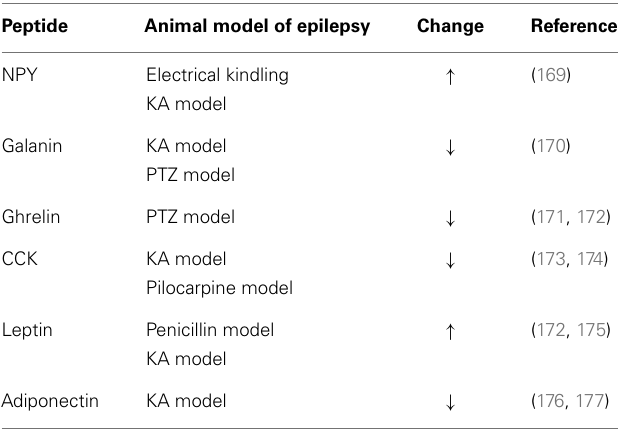
Table 4 | Changes in the levels of neuroactive peptides following seizures